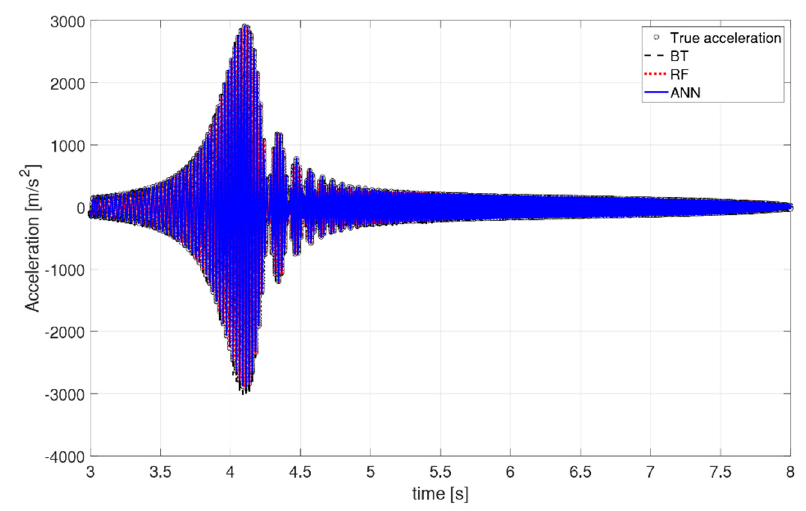
Figure 12. Snapshot of time history at x = 0.2057 m.